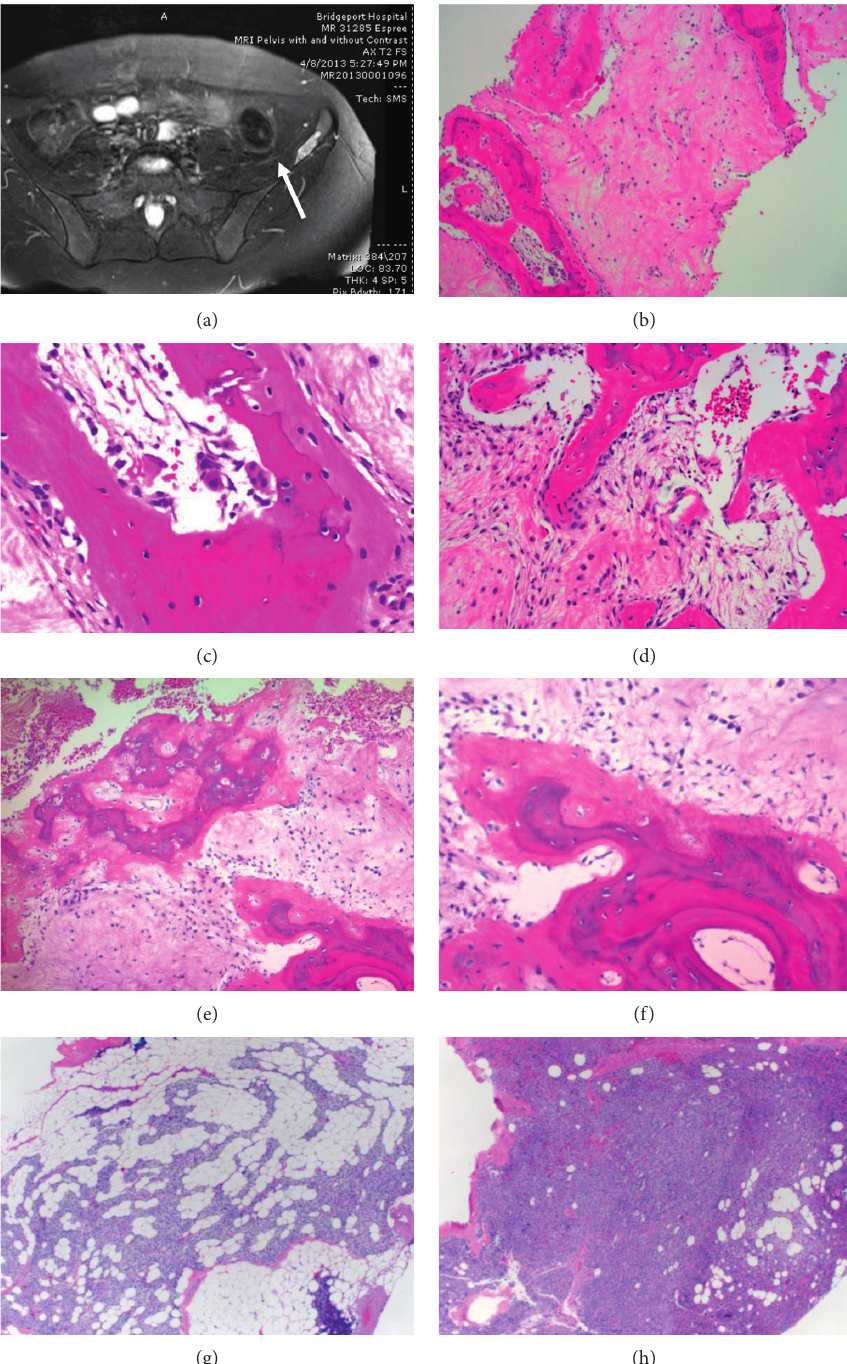
Figure 1: Bone imaging and bone and parathyroid histology. (a–f) Bone. (a) Initial MRI in 2013 showing bony lesion on the left iliac wing (bright area, white arrow) and (b–d) bone biopsy from 2013 reported as consistent with osteitis fibrosa cystica. Woven bone with marrow fibrosis (b), multinucleated osteoclasts with bone resorption (c), and osteoblastic rimming of new woven bone (d). (e) Repeat biopsy showing woven bone and peritrabecular fibrosis, with magnified portion (f). (g, h) Parathyroid. (g) Left lower parathyroid partial resection H&E stain, the specimen weighed 20 mg and measured 0.4cm. Parenchyma was approximately 50% parathyroid epithelial cells (pre- dominantly chief cells) and 50% adipocytes. (h) Right upper parathyroid gland biopsy, H&E stain, the specimen weighed 16mg and measured 0.6cm. Compared to that in (g), the parathyroid parenchyma is composed of approximately 80% parathyroid epithelial cells (predominantly chief cells) and 20% adipocytes. The amount of cellularity may be seen in normal parathyroid tissue or in hyperplasia. An additional biopsy of the left upper parathyroid gland was performed and was within normal limits based on weight and cellularity (not